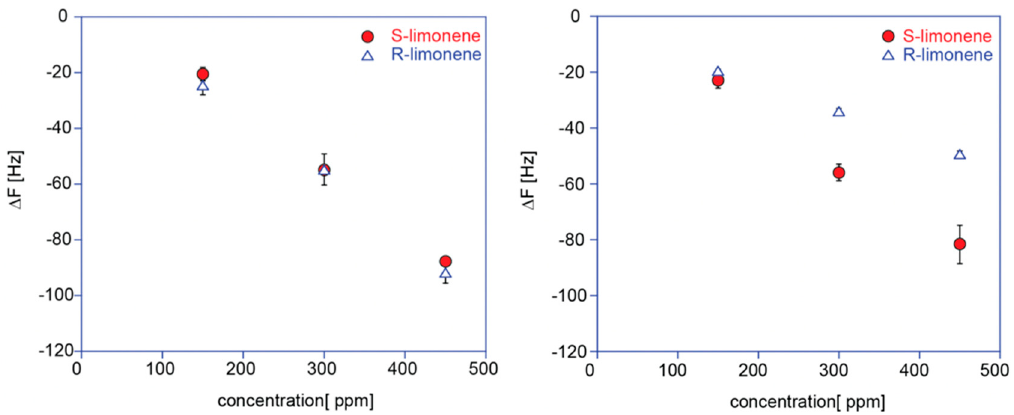
Figure 2. Response curve to limonene enantiomers of chiral porphyrin on gold ( left ) and ZnO nanoparticles ( right